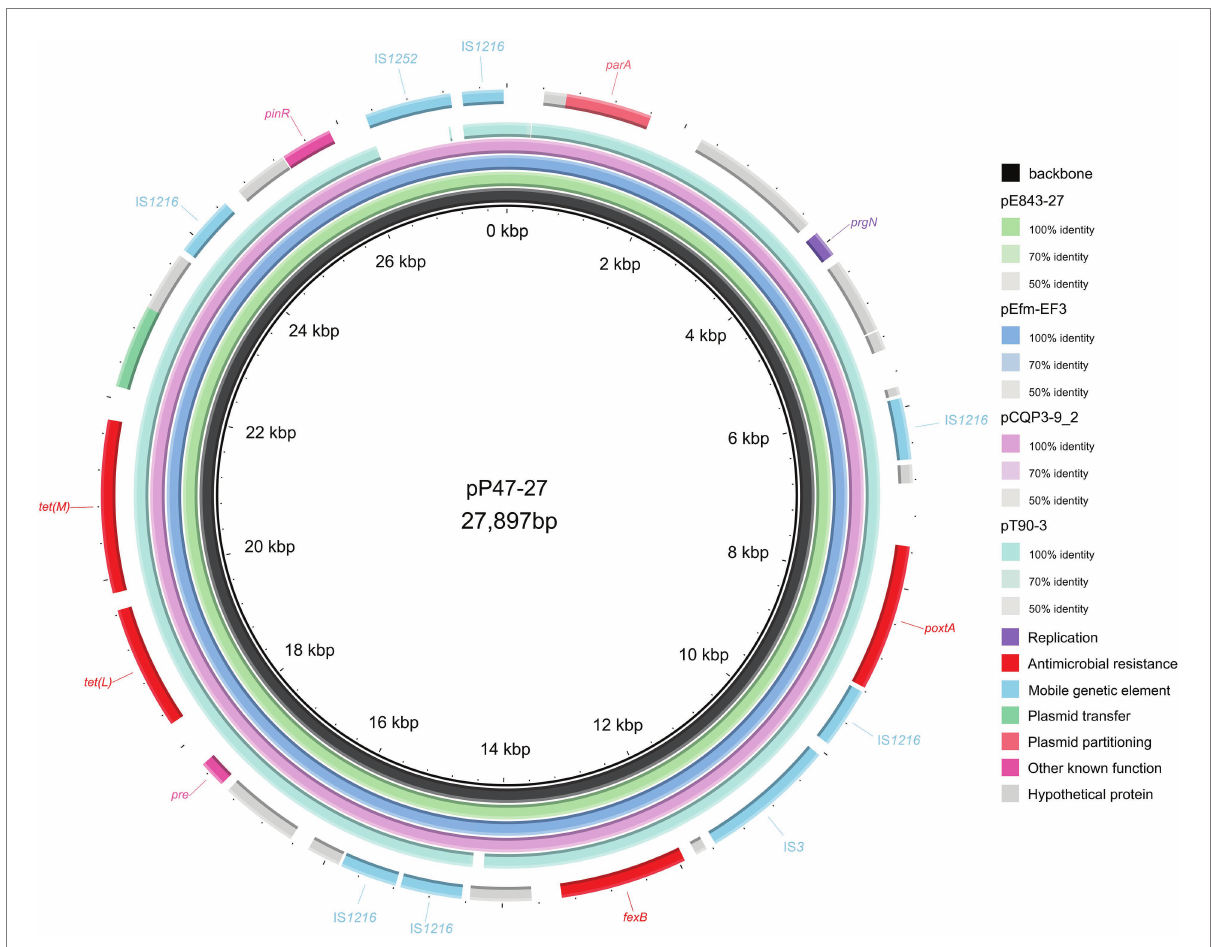
FIGURE 2 Comparative plasmid analysis of pP47-27 and other similar plasmids. The inside to the outside is as follows: circle 1, the backbone of pP47-27; circle 2, pE843-27 (the plasmid of Enterococcus lactis E843 isolated from swine, CP082268.1); circle 3, pEfm-EF3 (the plasmid of Enterococcus faecium EF3 isolated from marine sediment, MT683615.1); circle 4, pCQP3-9_2 (the plasmid of Enterococcus hirae pCQP3-9 isolated from fecal sample, CP037957.1); circle 5, pT90-3 (the plasmid of Enterococcus faecalis strain T90-3 isolated from swine, CP069131.1); and circle 6, the genes encoded on